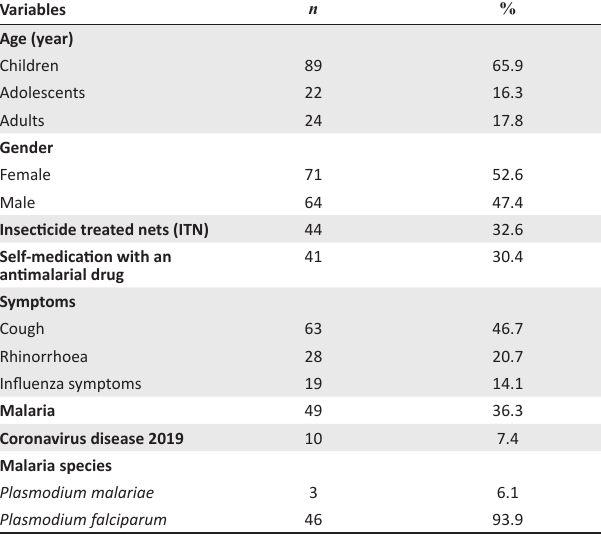
TABLE 1: Main characteristics of the study